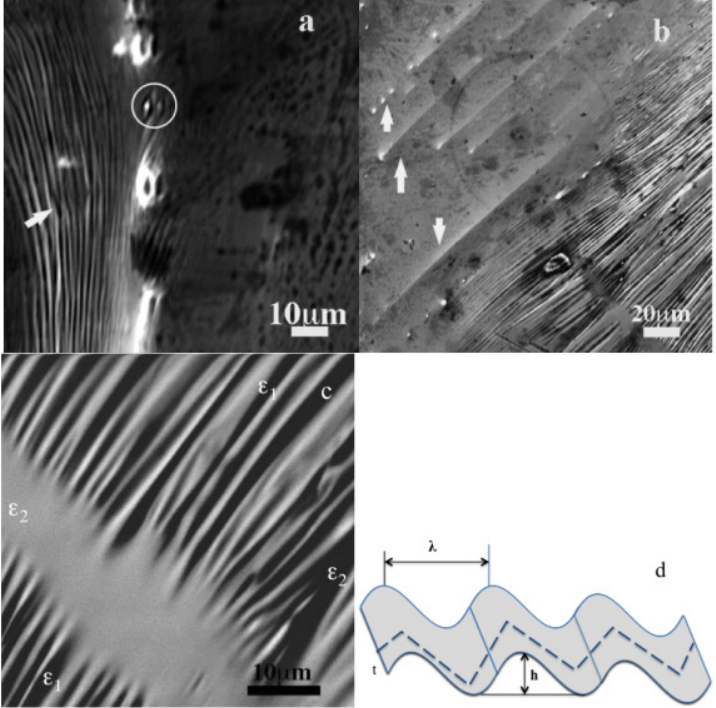
Figure 10. ( a ) SEM-SEI micrograph of wrinkles on as cast surface of Fe (Zr3) BMG strip: note the polyhedral-like grains; ( b ) SEM-BEI micrograph of as cast surface of Fe Mo B Zr (Zr3) BMG strip; needles and wrinkles; ( c ) SEM-BEI image of 66 6 18 10 wrinkles presumably under two strain directions: ε wrinkling and the serration (discontinuous line) on the surface of the BMG; λ wrinkle wavelength, h wrinkle amplitude, t surface